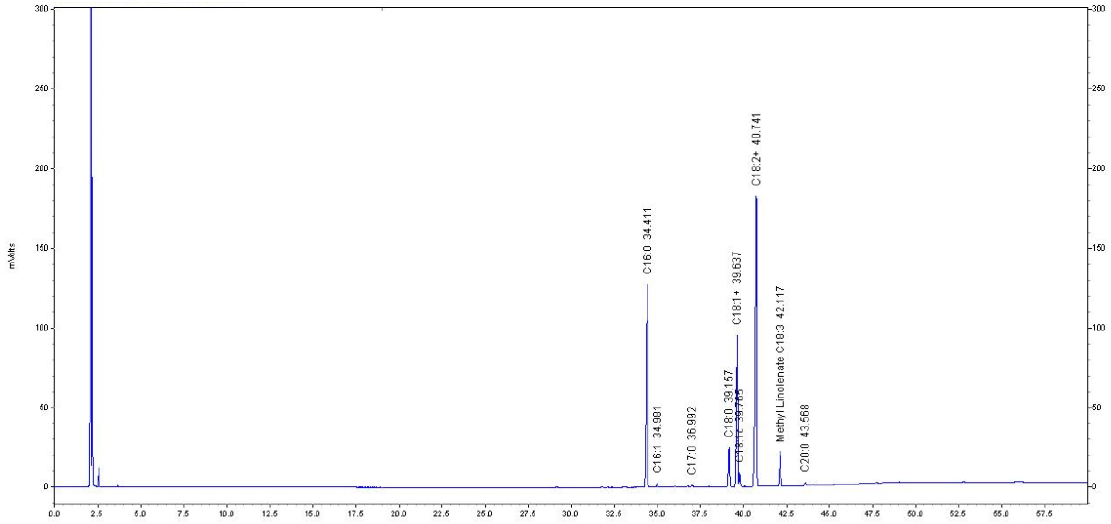
Figure 9. Fatty Acid Profile of the mandarin methyl esters.